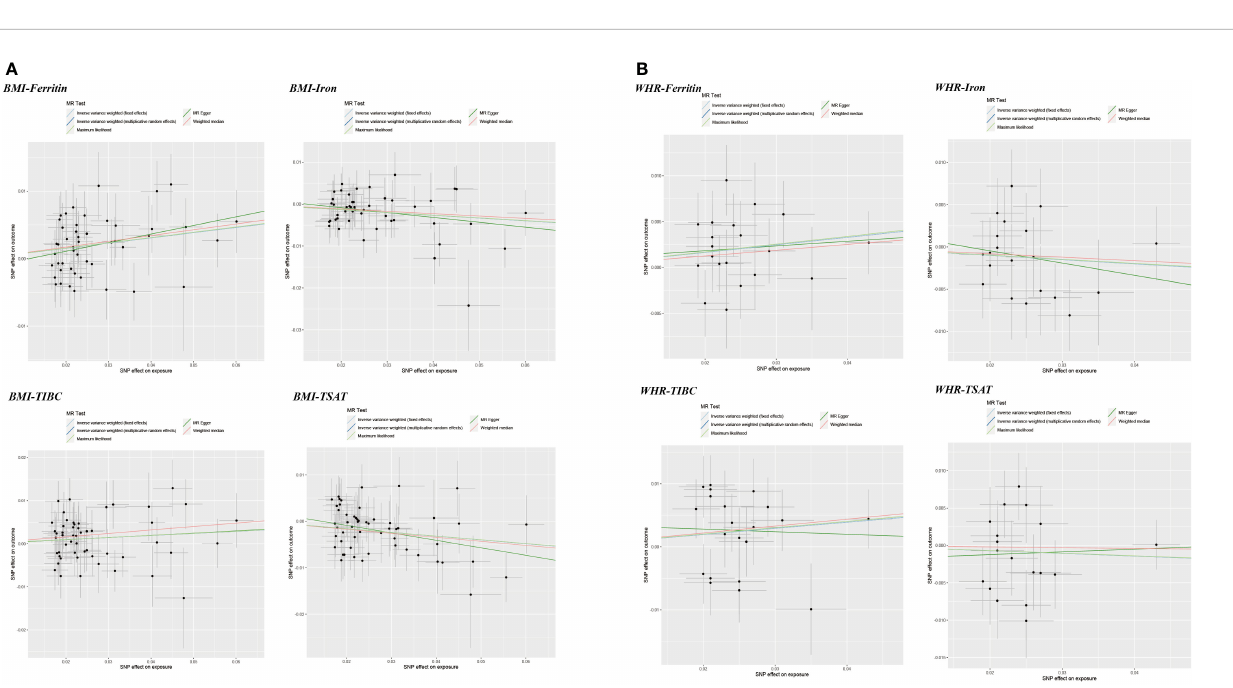
FIGURE 4 Scatter plots of Mendelian randomization analyses of the association between genetically predicted obesity-related traits and iron status. (A) BMI - serum ferritin, serum iron, TIBC and TSAT; (B) WHR - serum ferritin, serum iron, TIBC and